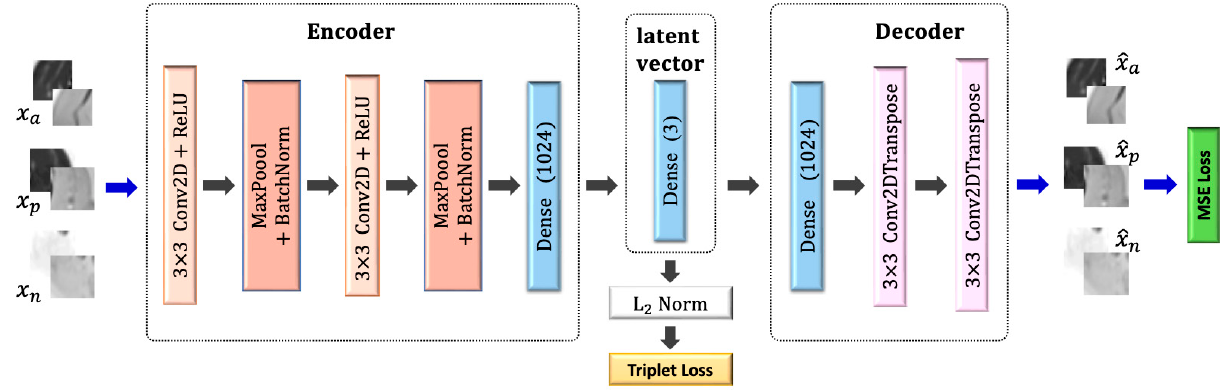
Figure 5. Schematics of the deep convolutional auto-encoder architecture and the loss terms used for the automatic classification of muscle